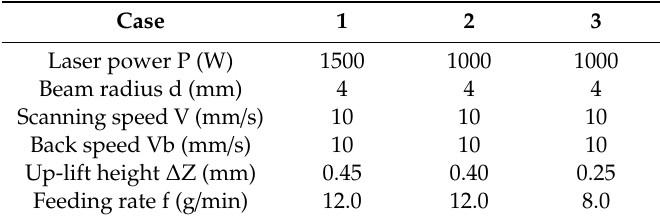
Figure 2. Rectangular part: ( a ) part dimensions (mm) and locations of the thermocouples and displacement sensors; ( b ) building path. Table 1. Processing parameters of laser directed energy deposition (L-DED). Table 1. Processing parameters of laser directed energy deposition (L-DED).